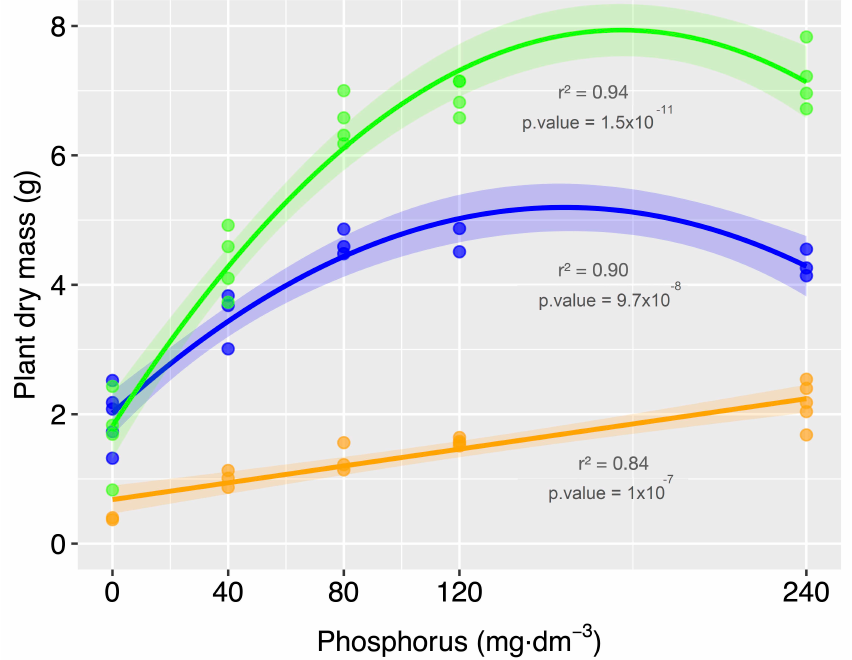
Figure 3. Total dry biomass of D. apurensis in response to P dose without the application of organic amendments (green), with aça í biochar (blue), and with compost (orange).